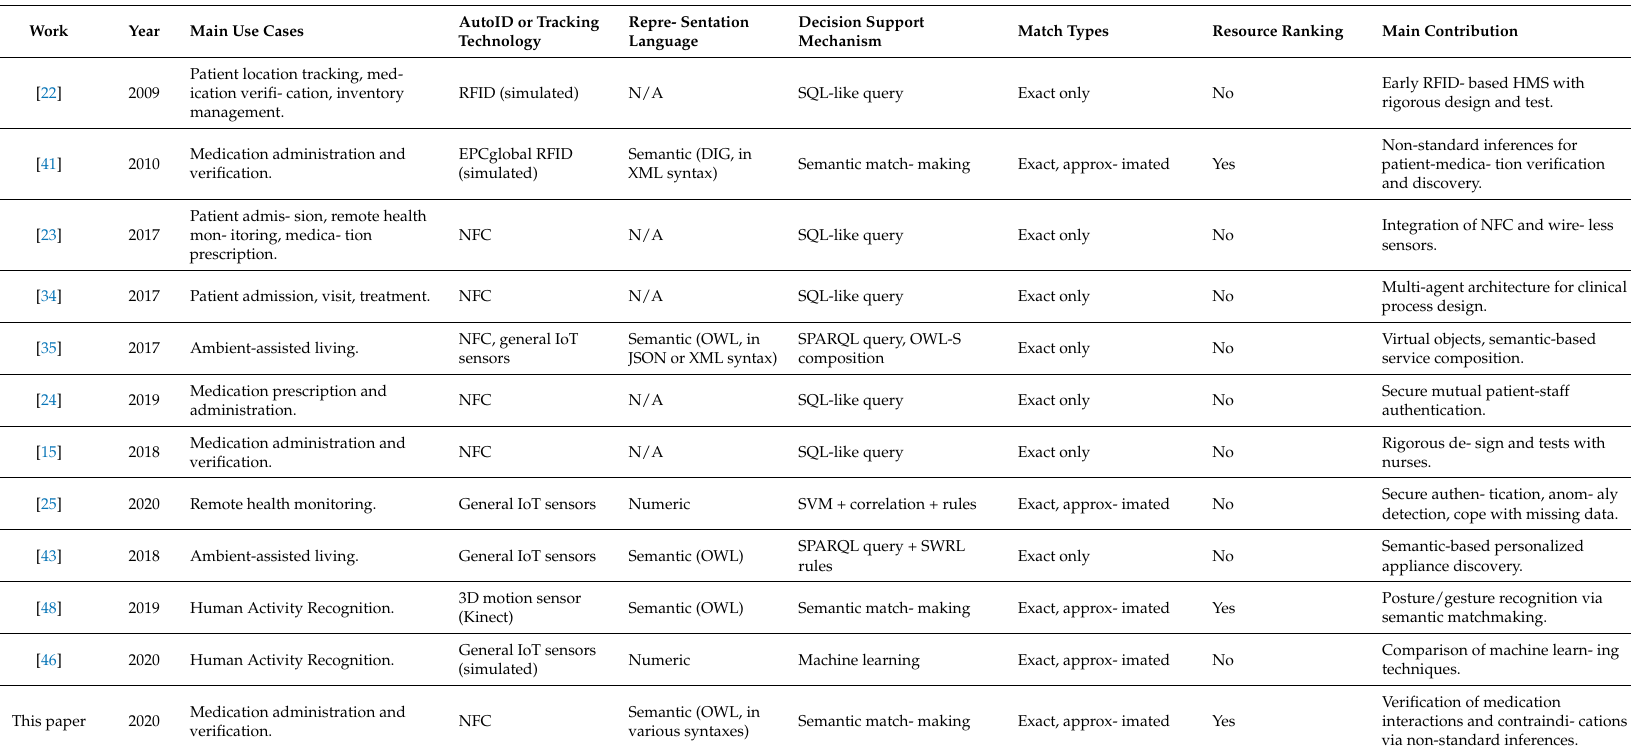
Table 1. Comparison of the proposed approach with related Clinical Decision Support